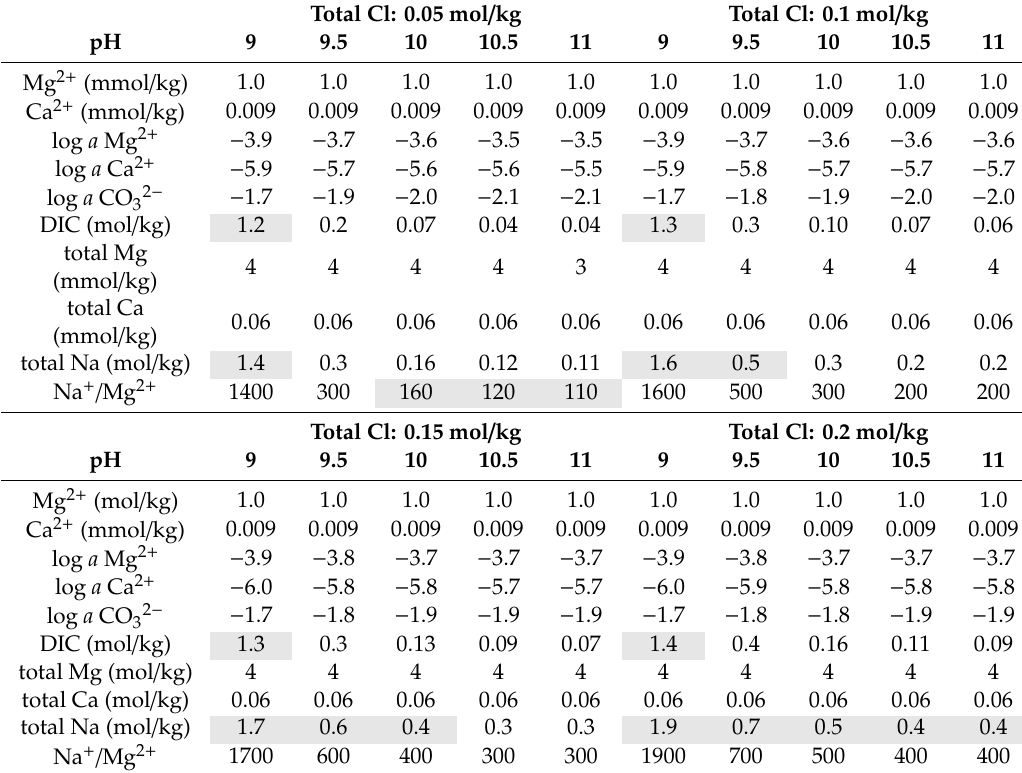
Table 2. Thermodynamic calculations of solution chemistries equilibrated with MHC and AMC at conditions of Enceladus’ subsurface ocean, as estimated from Cassini’s CDA results: pH 9–11, 0.05–0.2 mol Cl / kg, and 1 mmol Mg 2 + / kg (upper limit).